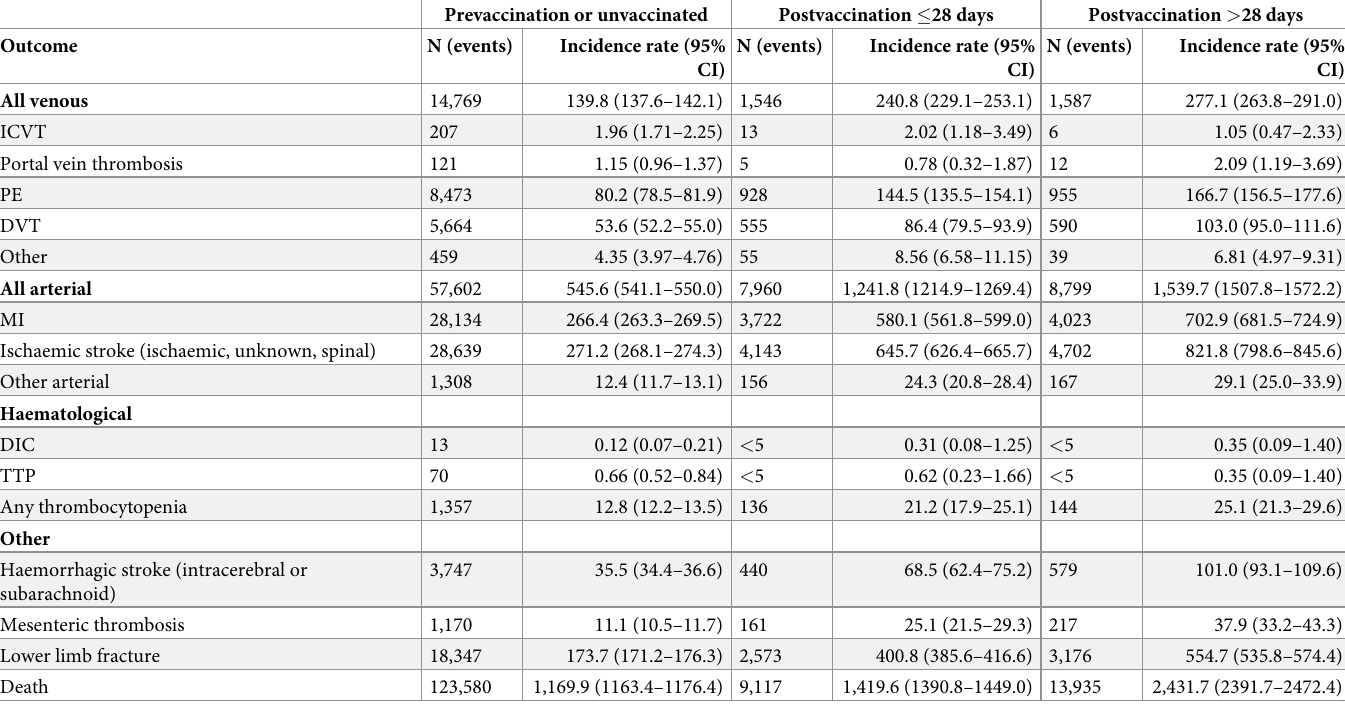
Table 3. Numbers and incidence rates pre- and post-first BNT162b2. Incidence rate per 100,000 person years. Disclosure control prevents presentation of n >